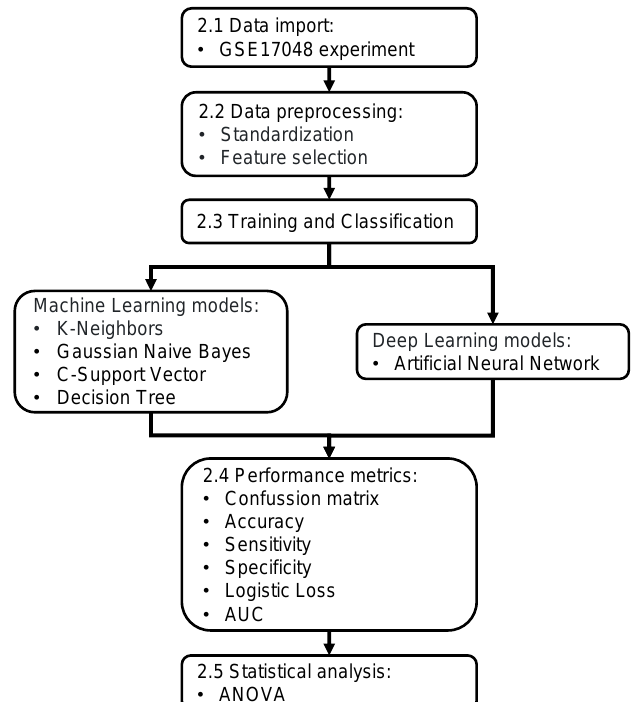
Figure 1. Proposed methodology. The gene data are obtained from the database and posteriorly standardized. The most relevant features are selected to train the compared prediction models and classify the individuals: healthy/MS. Then, the performance metrics are computed with the obtained predictions and the results are compared. Finally, the ANOVA test is performed to validate the effectiveness of the proposed ANN